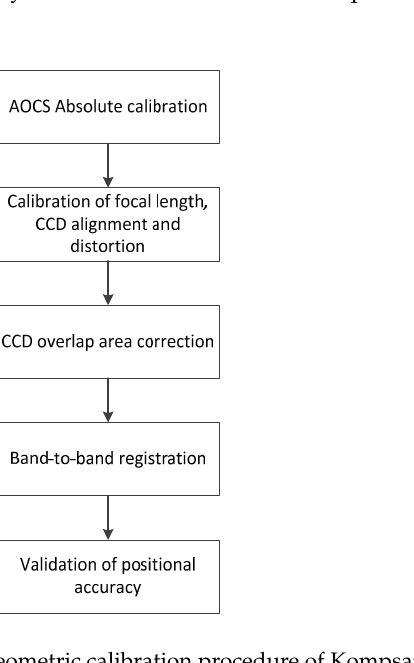
Figure 4. Summarized geometric calibration procedure of Kompsat-3A.